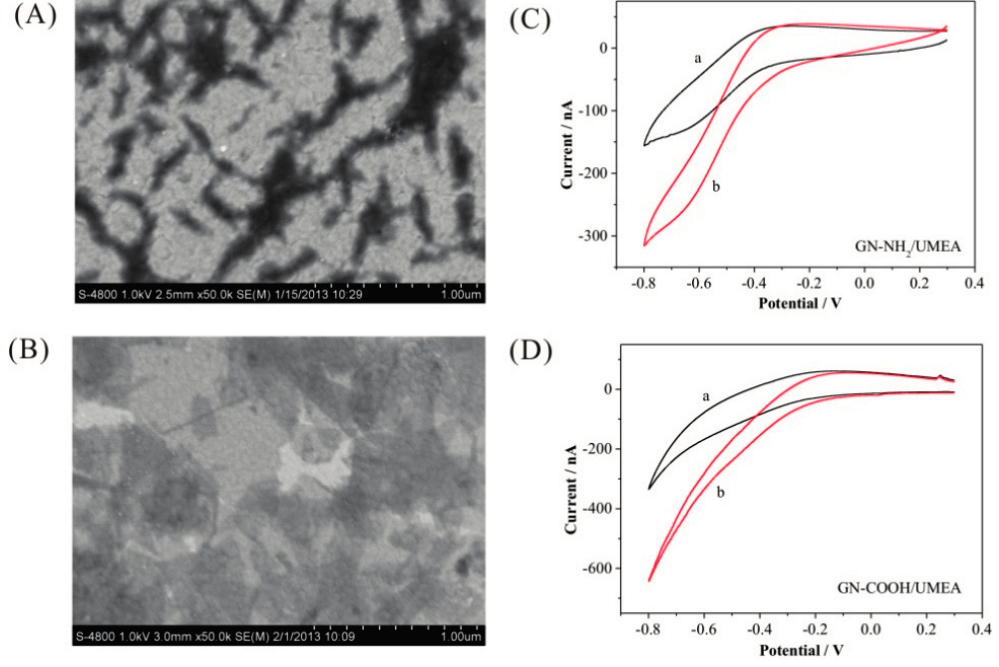
Figure 4. SEM images of GN-NH 2 ( A ) and GN-COOH ( B ); Response of GN-NH 2 /UMEA ( C ) and GN-COOH/UMEA ( D ) in absence (a) and presence (b) of